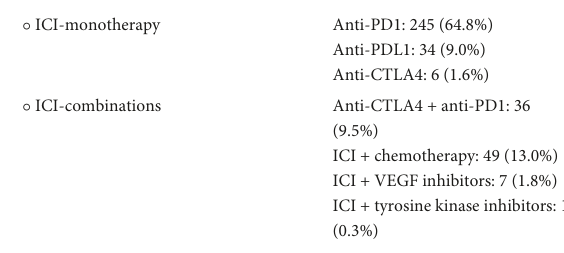
TABLE 1 Baseline characteristics of patients at the time of initial administration of immune checkpoint inhibitors.